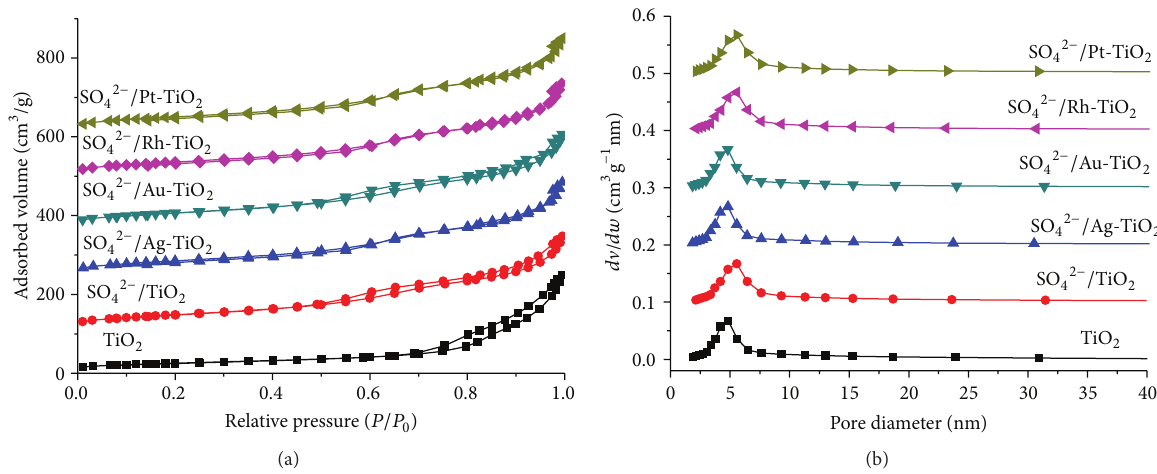
Figure 2: (a) N 2 -sorption isotherms and (b) corresponding pore-size distribution curves for the samples.